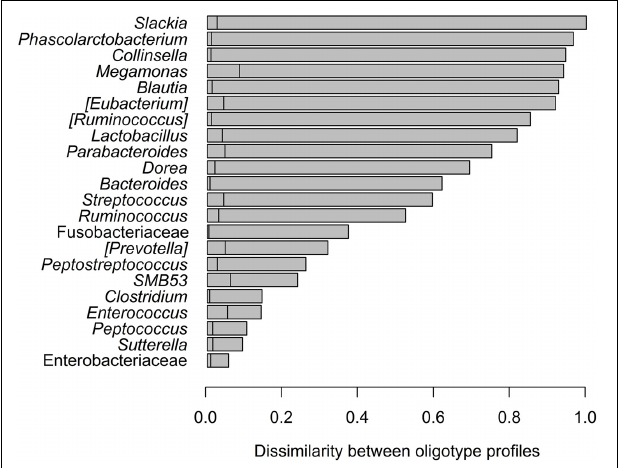
FIGURE 5 | Dissimilarity in oligotype profiles for each bacteria taxon shared between cheetahs and black-backed jackals. Observed dissimilarities are ranked from highest (top) to lowest differences (bottom). The vertical lines in each horizontal bar represent the 95% quantile above which differences between the observed and randomized dissimilarities become statistically significant. All observed dissimilarities were higher than randomized ones ( p < 0 .